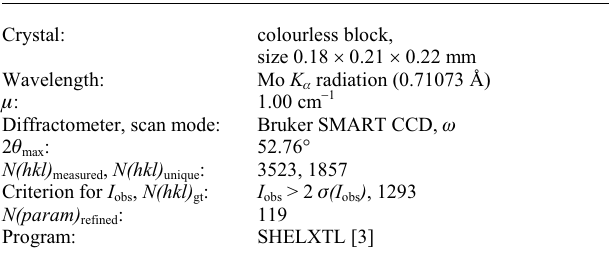
Table 1. Data collection and handling.